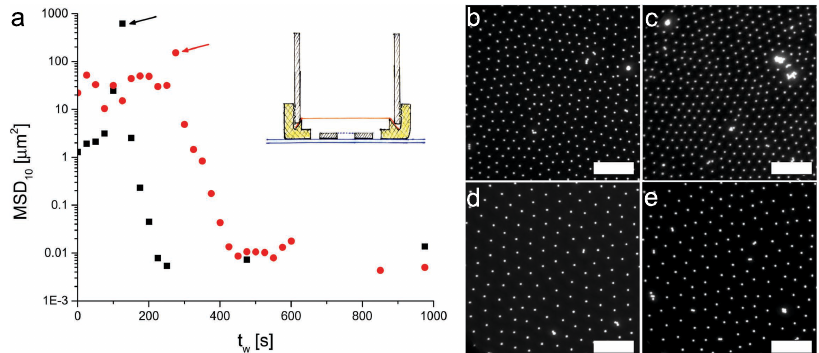
Figure 5. ( a ) MSD calculated after 10 seconds for 2.8 µ m PS particles at a water–decane interface during the interfacial polymerization of nylon plotted as a function of waiting time after injection of sebacoyldichloride, with ( red ) and without ( black ) filter paper. The arrows mark the points of highest particle mobility due to convective Marangoni flows at the interface. Inset: schematic of the sample cell used for the measurements. The horizontal dashed line represents the interface and the red line depicts the filter paper membrane; ( b – e ) fluorescence images of the particles at the interface before ( b and d ) and after polymerization ( c and e ), showing no qualitative difference in the microstructure. Images ( b ) and ( c ) are taken without the filter paper membrane; ( d ) and ( e ) with the filter paper membrane. The scale bars are 50 µ